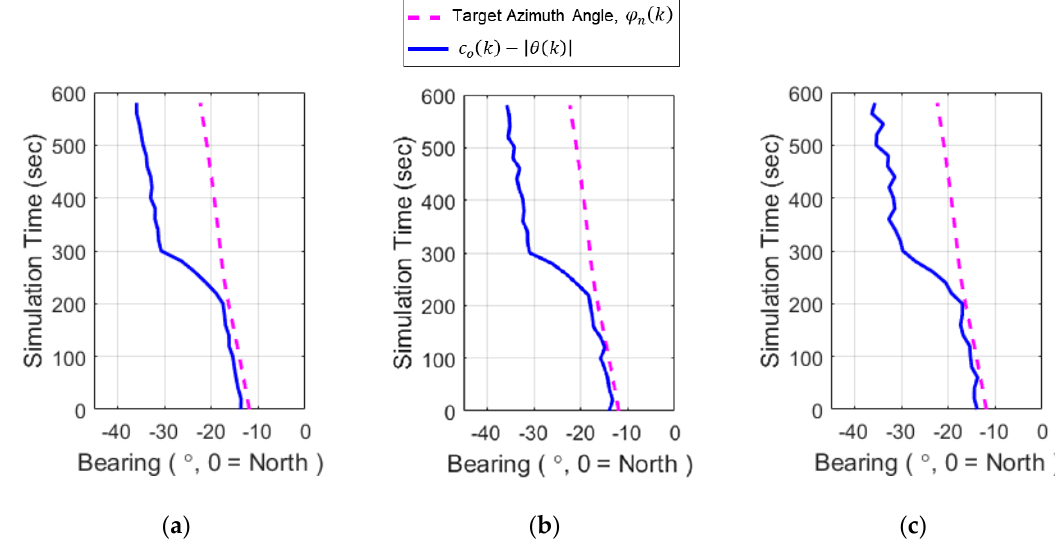
Figure 7. The BTRs for conical angle measurements including Gaussian measurement error with zero mean and standard deviation of ( a ) 0.2, ( b ) 0.4, and ( c ) 0.6 ° .